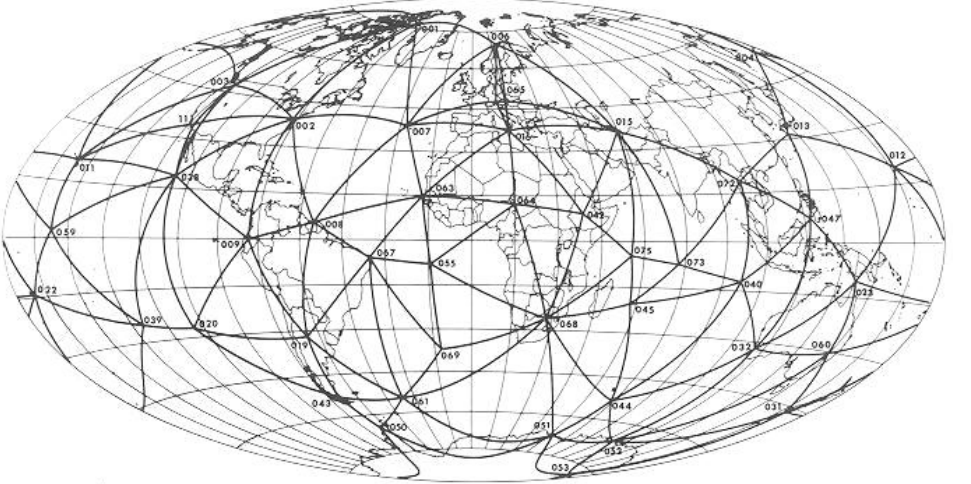
Figure 4. Global network based on satellite triangulation with an accuracy of ± 2–8m (Schmid, 1974).